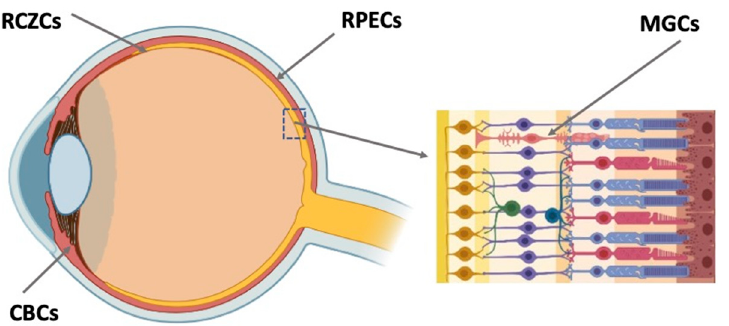
Figure 1. Potential endogenous cell sources for retinal regeneration (summarized data). RCZCs—cells of the retina ciliary zone; RPECs—retinal pigment epithelial cells; CBCs—cells of the ciliary body; MGCs—Müller glial cells.